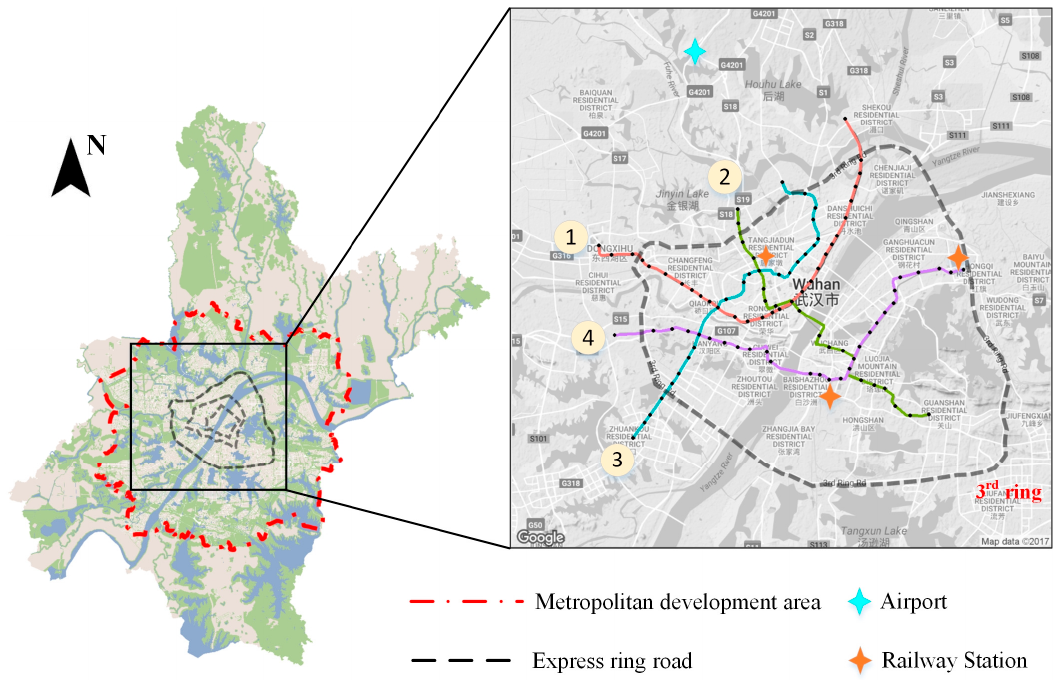
Figure 1. Metro lines in Wuhan. The area inside the 3rd express ring road is the core urban area of Wuhan.